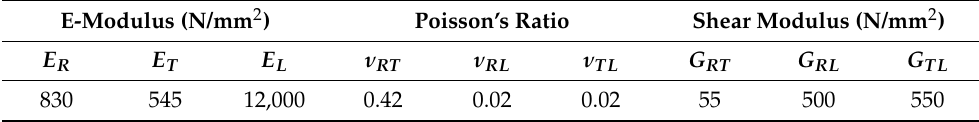
Table 3. Wood material’s elasticity properties for FE modeling.